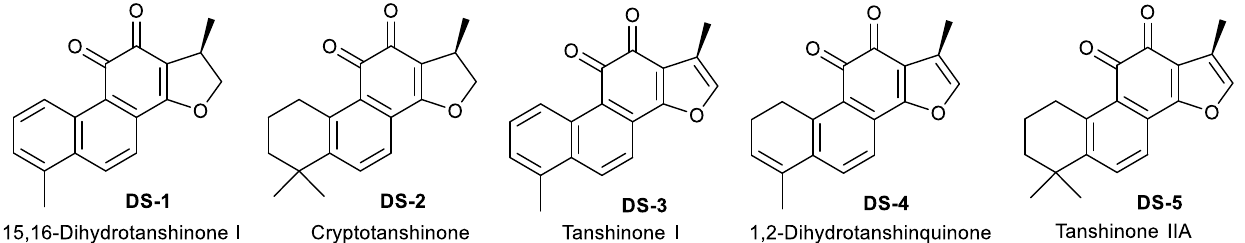
Figure 1. The chemical structures of 5 tanshinones isolated from the rhizome of Salvia miltiorrhiza Bunge.